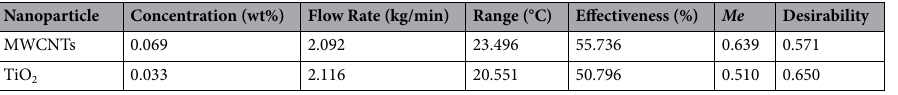
Table 16. The optimal values proposed by software for each parameter for optimization of MWCNTs and TiO 2 nanofluids.